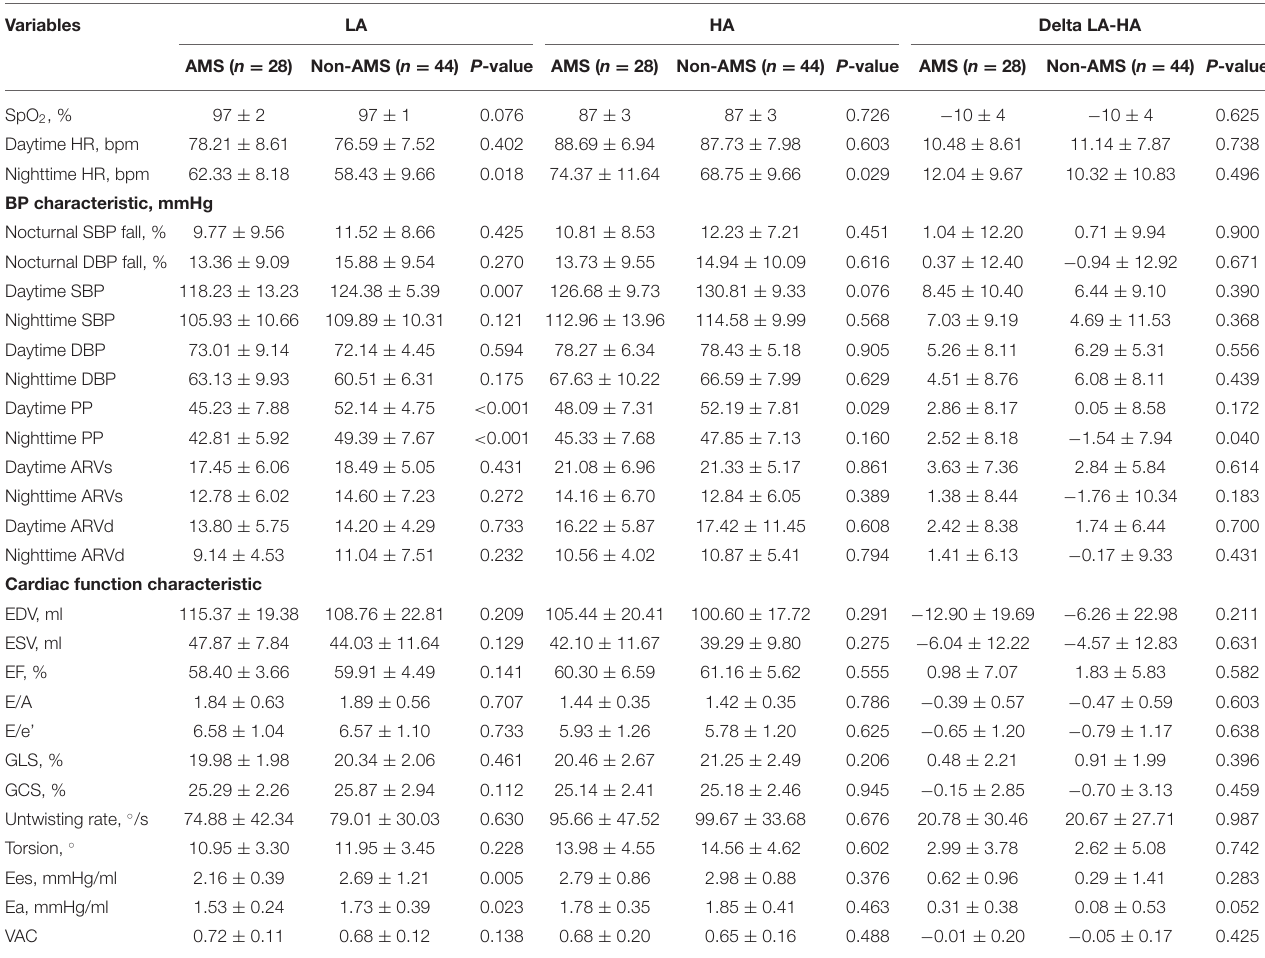
TABLE 2 | Effect of acute HA